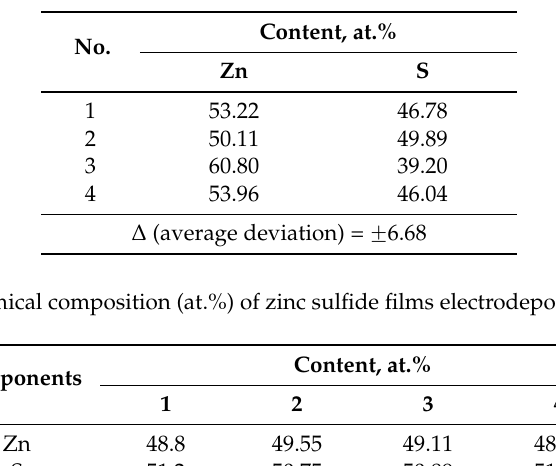
Table 1. Chemical composition (at.%) of zinc sulfide films electrodeposited at 70 ° C. No.